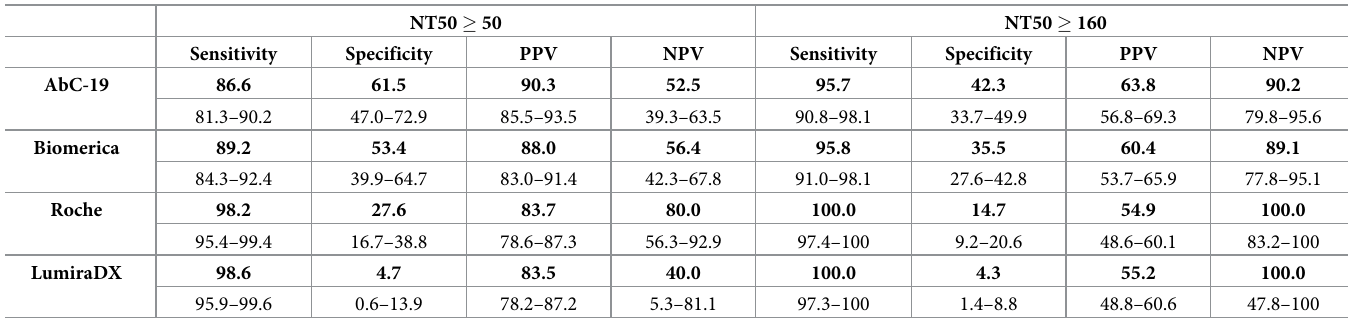
Table 4. Performance of POC devices compared to NT 50 � 50 and � 160.